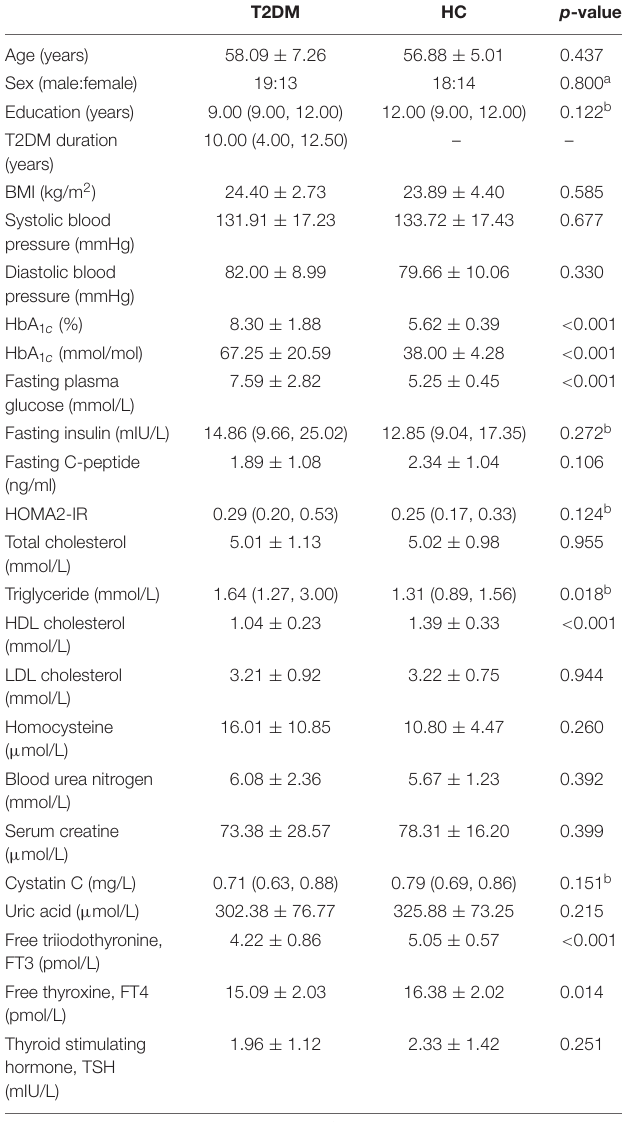
TABLE 1 | Demographic and clinical data of all included